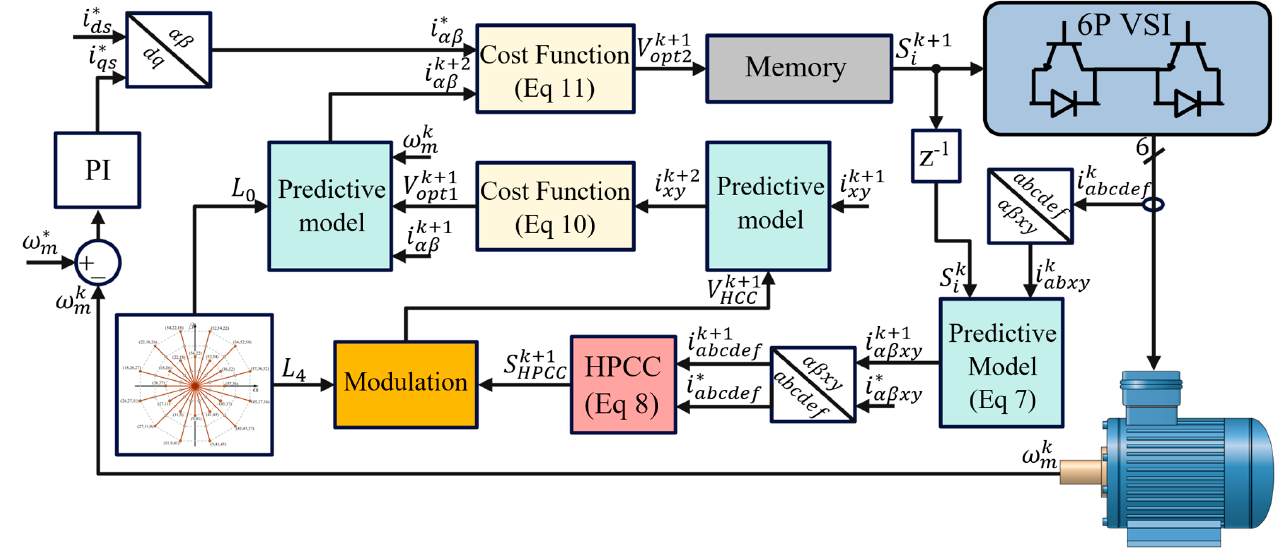
Figure 6. Proposed HMPCC scheme for an asymmetrical six-phase